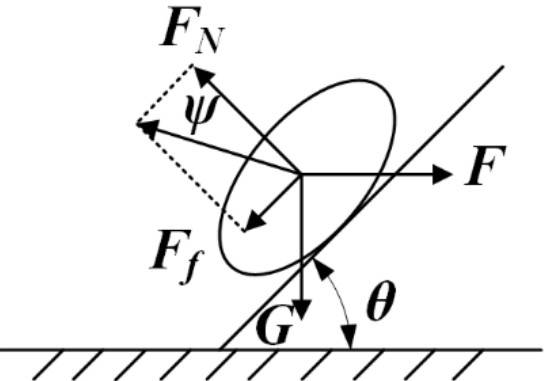
Figure 3. The force diagram of jujubes on comb teeth. Note: Where F is the force required for jujubes to climb in the direction of the comb teeth, N; G is the gravity of jujube, N; F N is the support force of the comb teeth for jujube, N; F f is the sliding friction between comb teeth and jujube, N; θ is the angle of the comb teeth entering the soil, (°); ψ is the friction angle, (°).